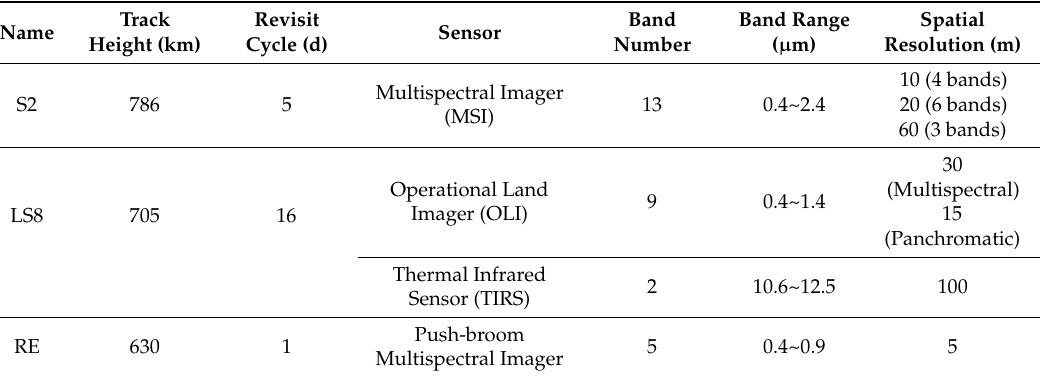
Table 2. Overview of satellite